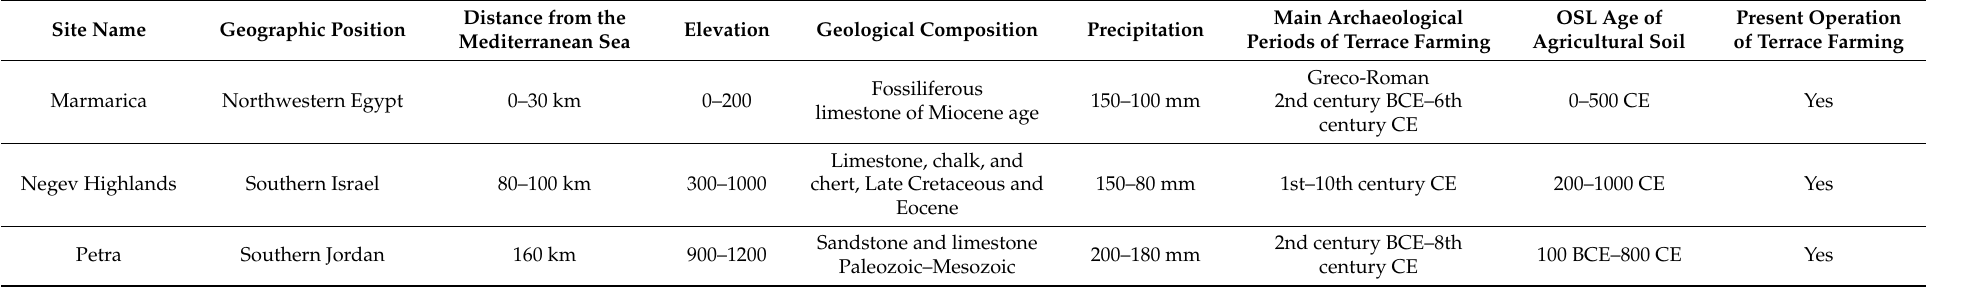
Table 1. Study sites and their geographical, geological, and archaeological